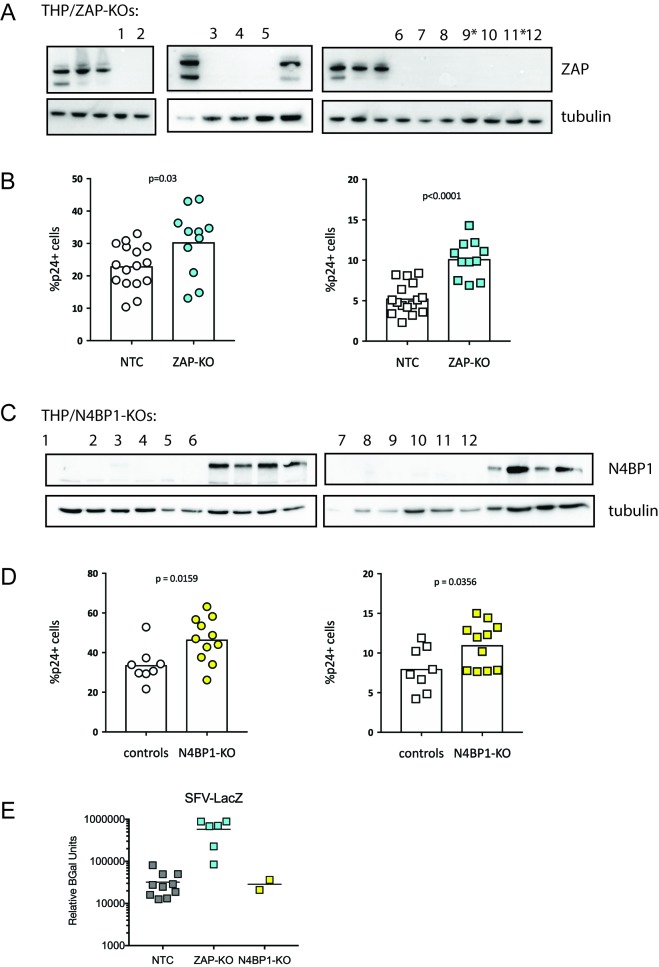
ZAP and N4BP1 are modest inhibitors of HIV infection.(A) Western blot confirming KO of ZAP in THP-1 clonal lines. *indicates clonal line used in PIKAHIV ZAP-KO screening (Figure 2B–E). (B) Control (gray) and ZAP-KO (cyan) clonal THP-1 cell lines were infected and %p24 +cells was measured 2 days post-infection. Left (circles): no IFN. Right (squares): pretreatment with 200 U/mL IFNα. (C) Western blot confirming KO of N4BP1 in THP-1 clonal lines. (D) Control (gray) and N4BP1-KO (yellow) clonal THP-1 cell lines were infected and %p24 +cells was measured 2 days post-infection. Left (circles): no IFN. Right (squares): pretreatment with 200 U/mL IFNα. (E) Clonal control (NTC - gray), ZAP-KO (cyan) or N4BP1-KO (yellow) THP-1 lines were infected with SFV-LacZ and assayed for beta-galactosidase expression the following day. *unpaired t-test.